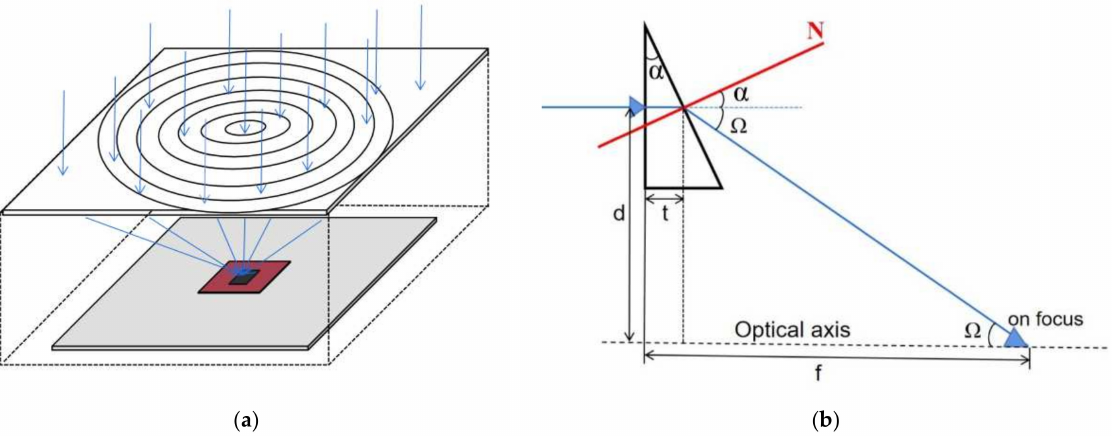
Figure 1. ( a ) The structure of the concentrating photovoltaic cell. ( b ) The geometrical relationships between the incident light and the refracted